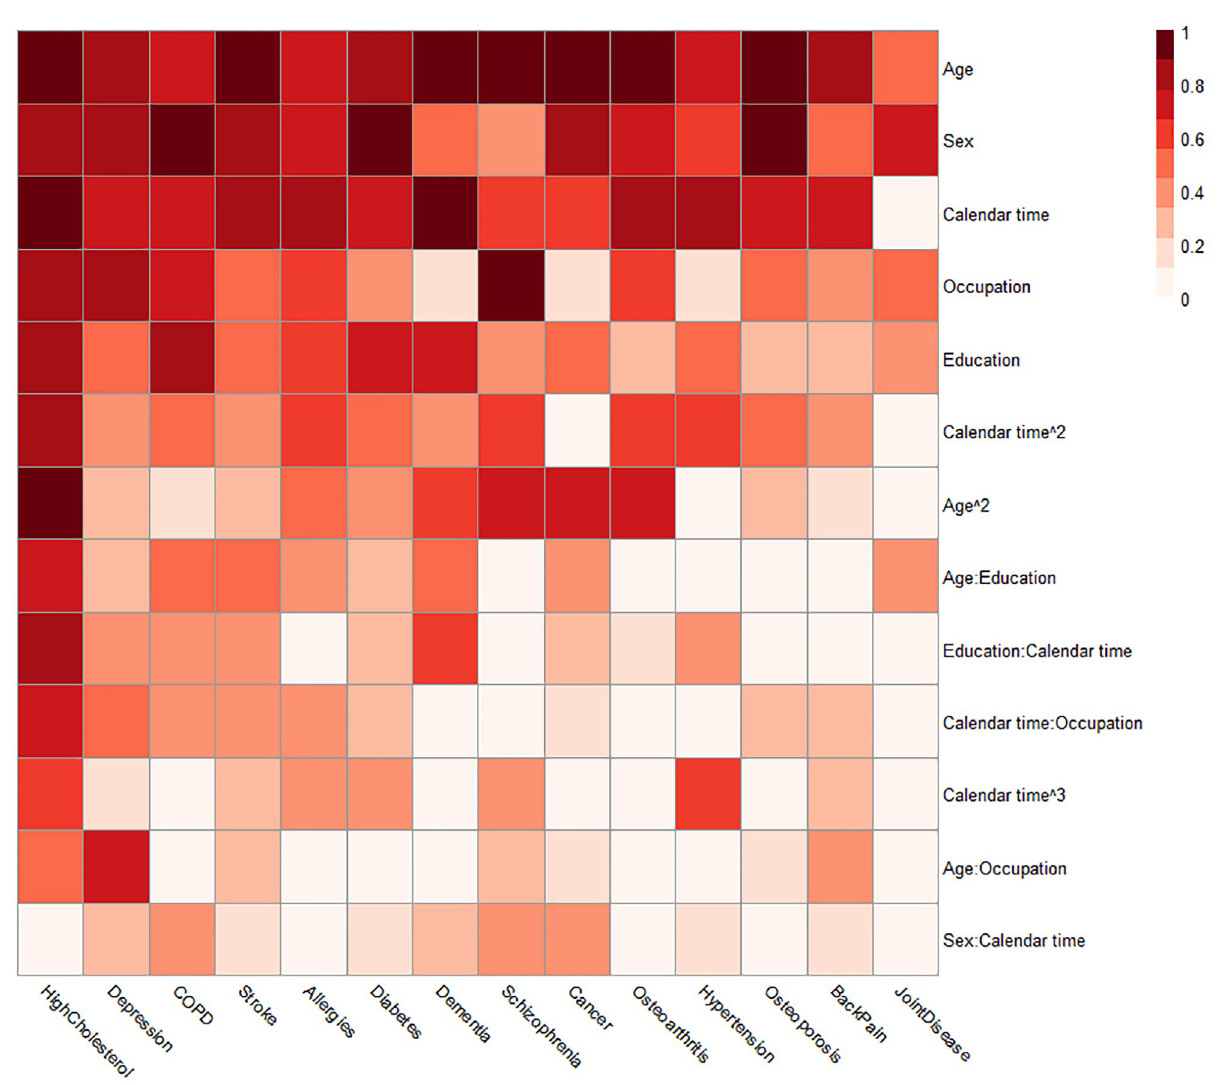
Fig 3. Heatmap on importance of different variables on transition probabilities to distinct next diagnosis endpoints. Results were obtained from a backwards selection of covariates where each unique disease portfolio was modelled separately for each next diagnosis endpoint. The importance of one indicates that the term was kept in all disease portfolios. The figure is sorted by sums of importance across endpoints (left to right) and across variables (top to